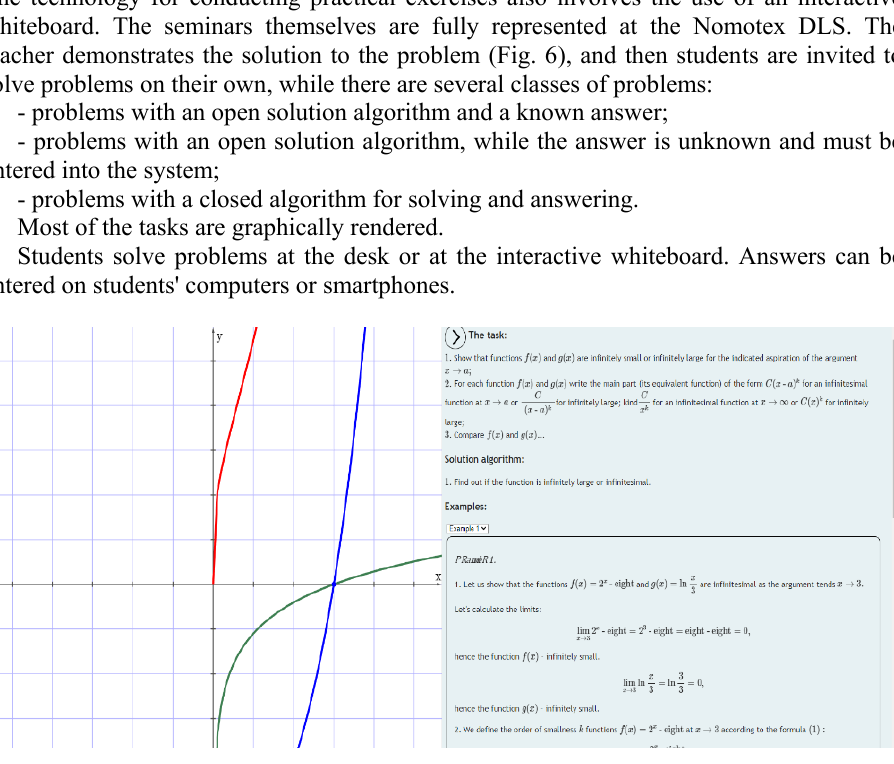
Fig. 6. Seminar problem with open solution algorithm and graphical visualization answer on the topic "Determining the order of one infinitely large function relative to another" in the Nomotex